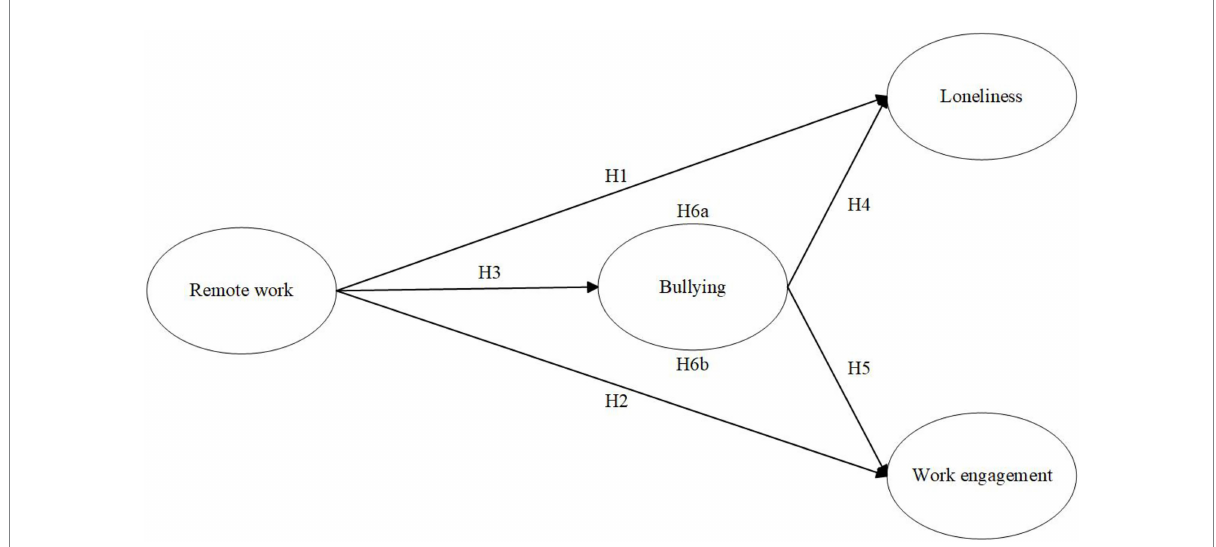
FIGURE 1 The research model, with letters referring to the presented